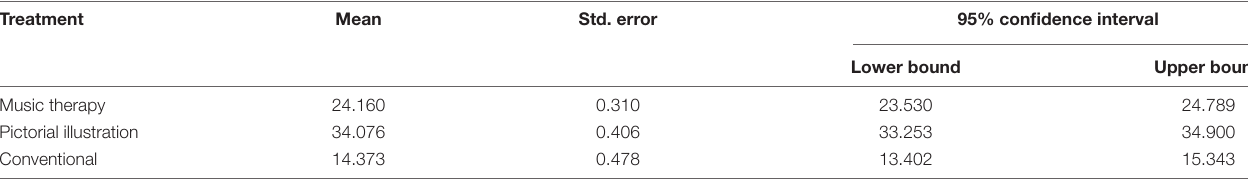
TABLE 2 | Estimated marginal means of post-attention span by treatment. Treatment